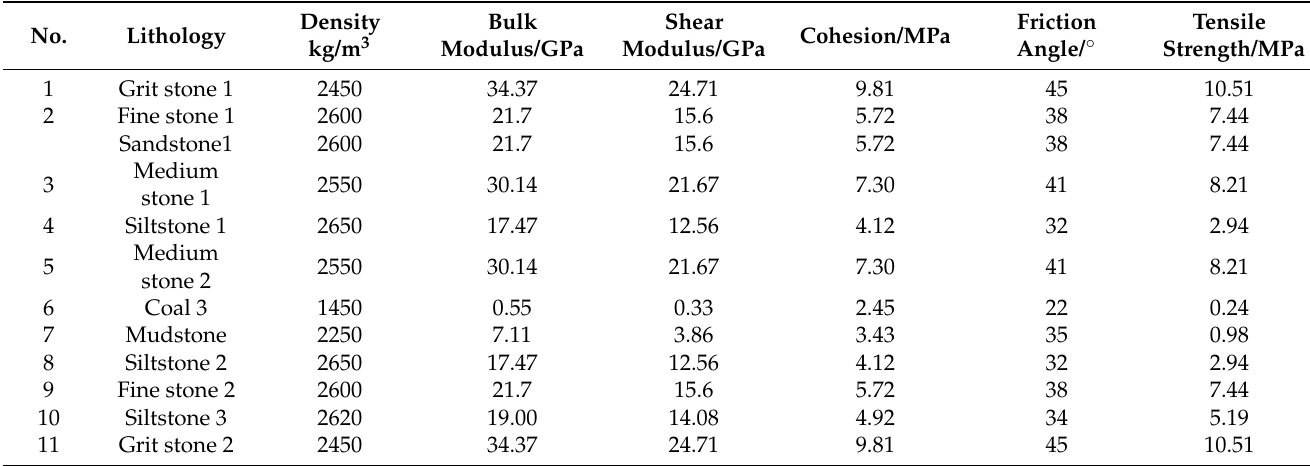
Figure 8. Simplified model diagram of boundary conditions. Table 4. Rock mass